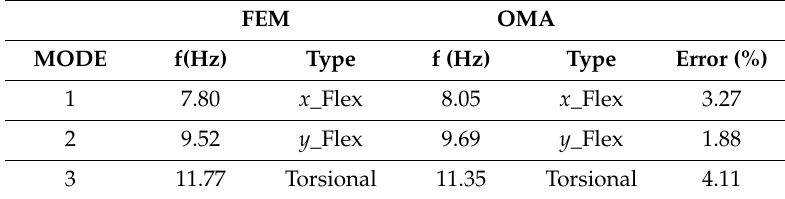
Table 5. Material properties and elements type adopted in the FE models—Structure B.